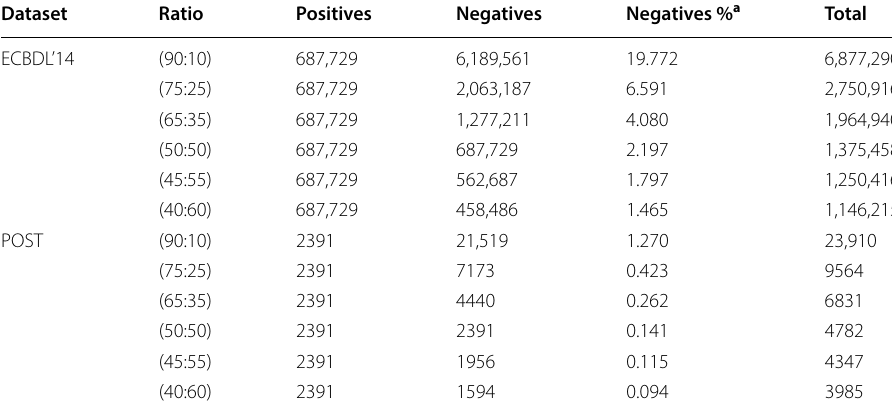
a Percentages of negatives are calculated based on the negative (unsampled) total size